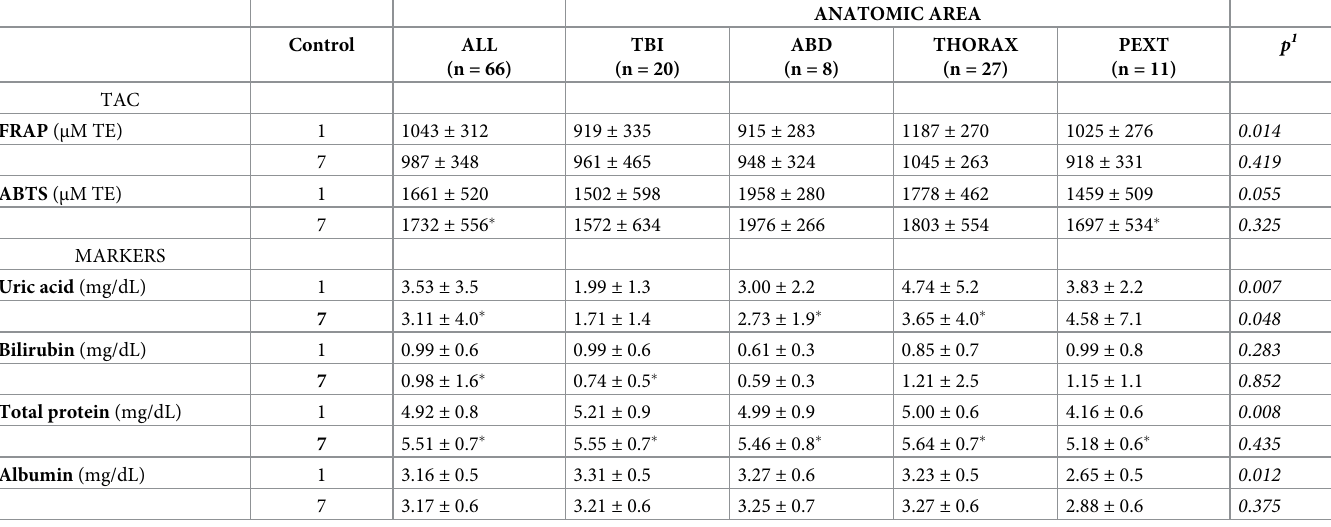
Table 2. Values of TAC and its components according to anatomic location and time after ICU entry.